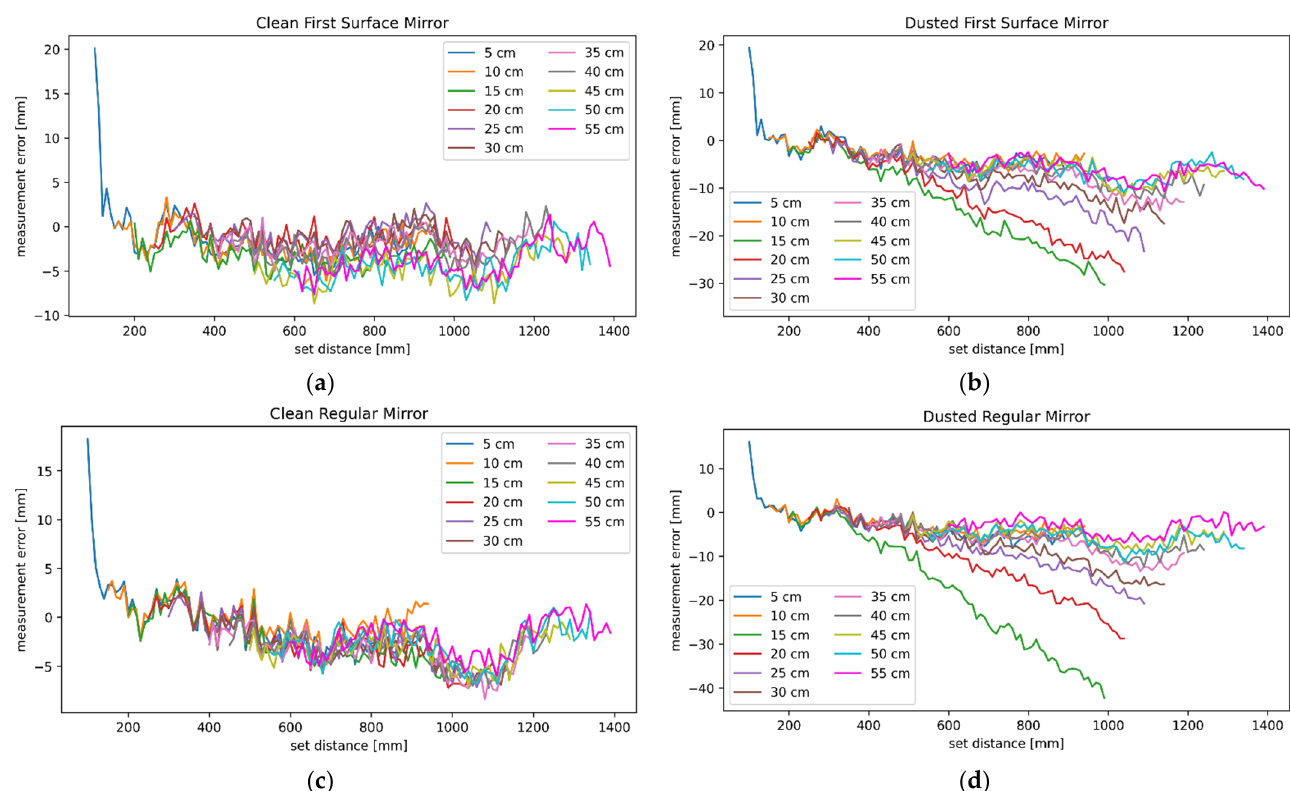
Figure 8. Measurement error measured on a clean ( a ) and dusted ( b ) protected first surface mirror, and clean ( c ) and dusted ( d ) regular mirror. Different traces correspond to configurations with different distances between ranging device and mirror’s reflecting surface. Blue trace corresponds to the configuration where this distance is 5 cm , and magenta trace for when it is 55 cm all other distances are displayed in the legend key.